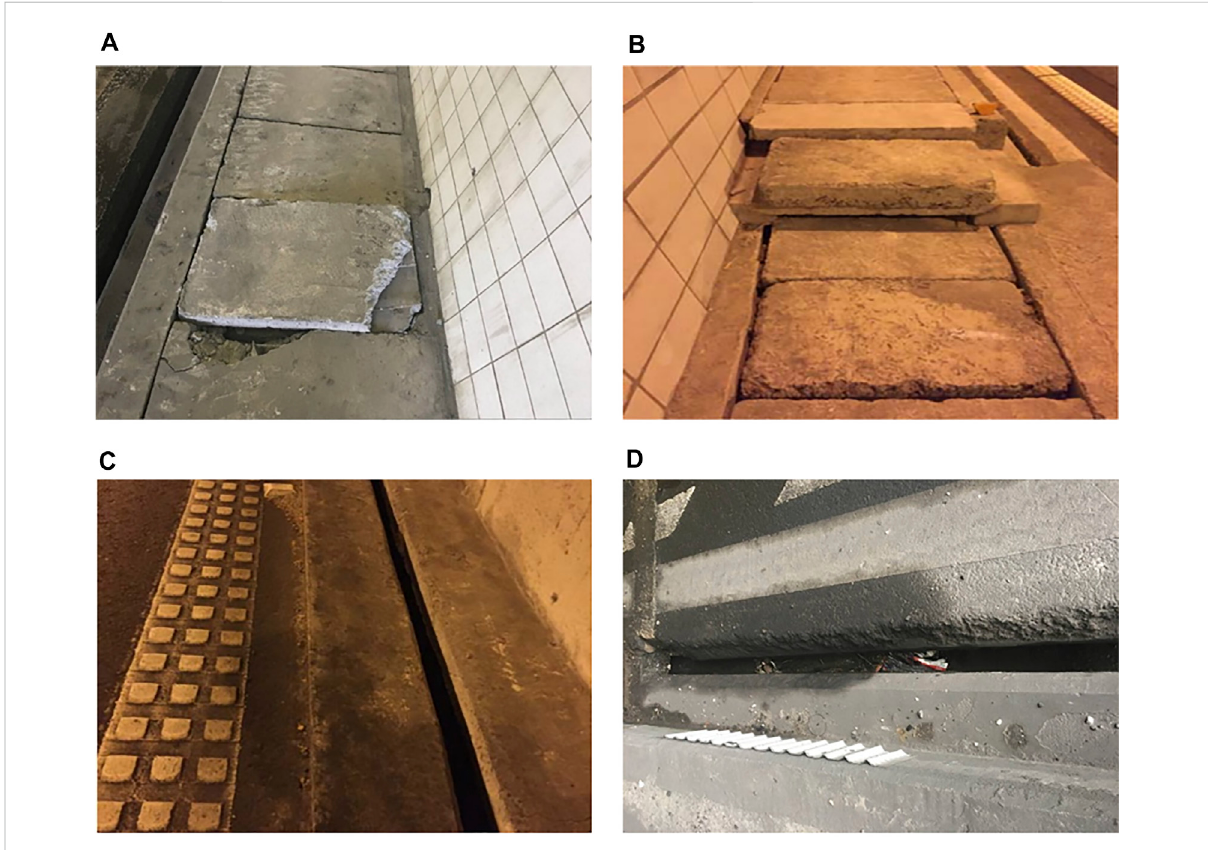
FIGURE 1 Photos of damaged traditional curb components: (A) cover plate missing corners, (B) fl atness of cover plate is poor, (C) slotted ditch above the road surface, and (D) debris clogged up in a slotted ditch.